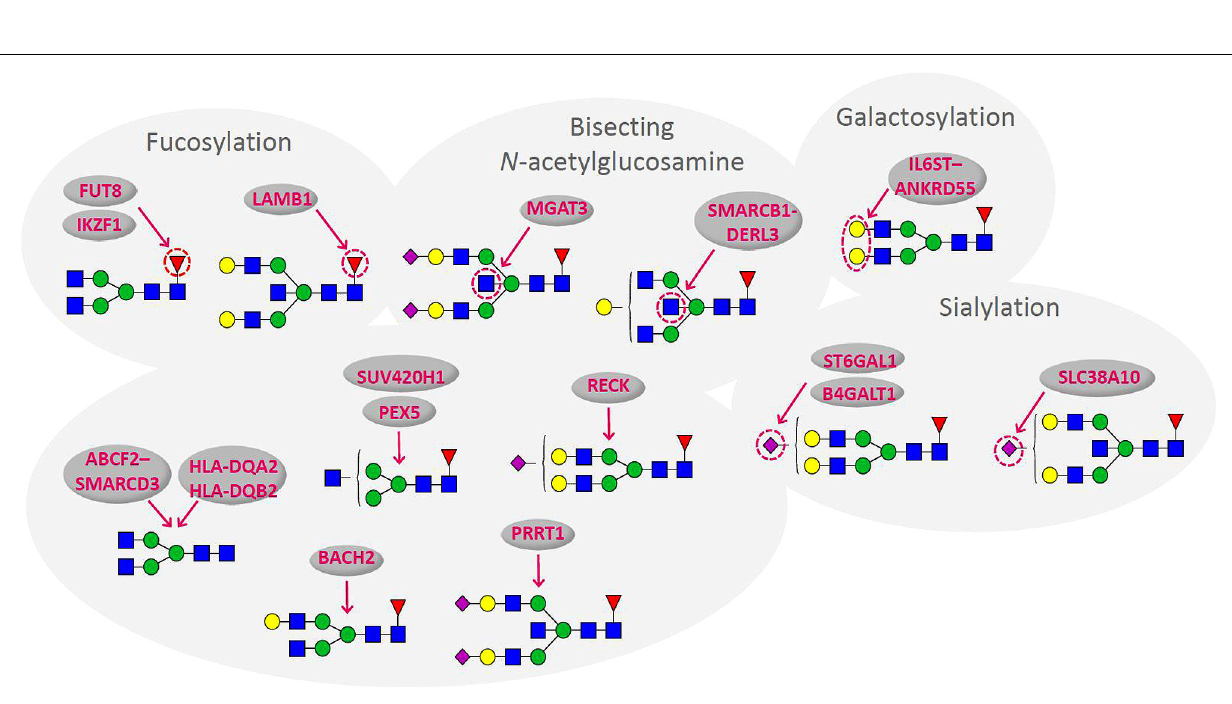
FIGURE 2 | Genes that associate with variations in the composition of the IgG glycome. Arrows indicate the part of glycan structure with which particular gene associates (Lauc etal., 2013). Blue square – N -Acetylglucosamine; green circle – mannose; yellow circle – galactose; red triangle – fucose; purple diamond – sialic